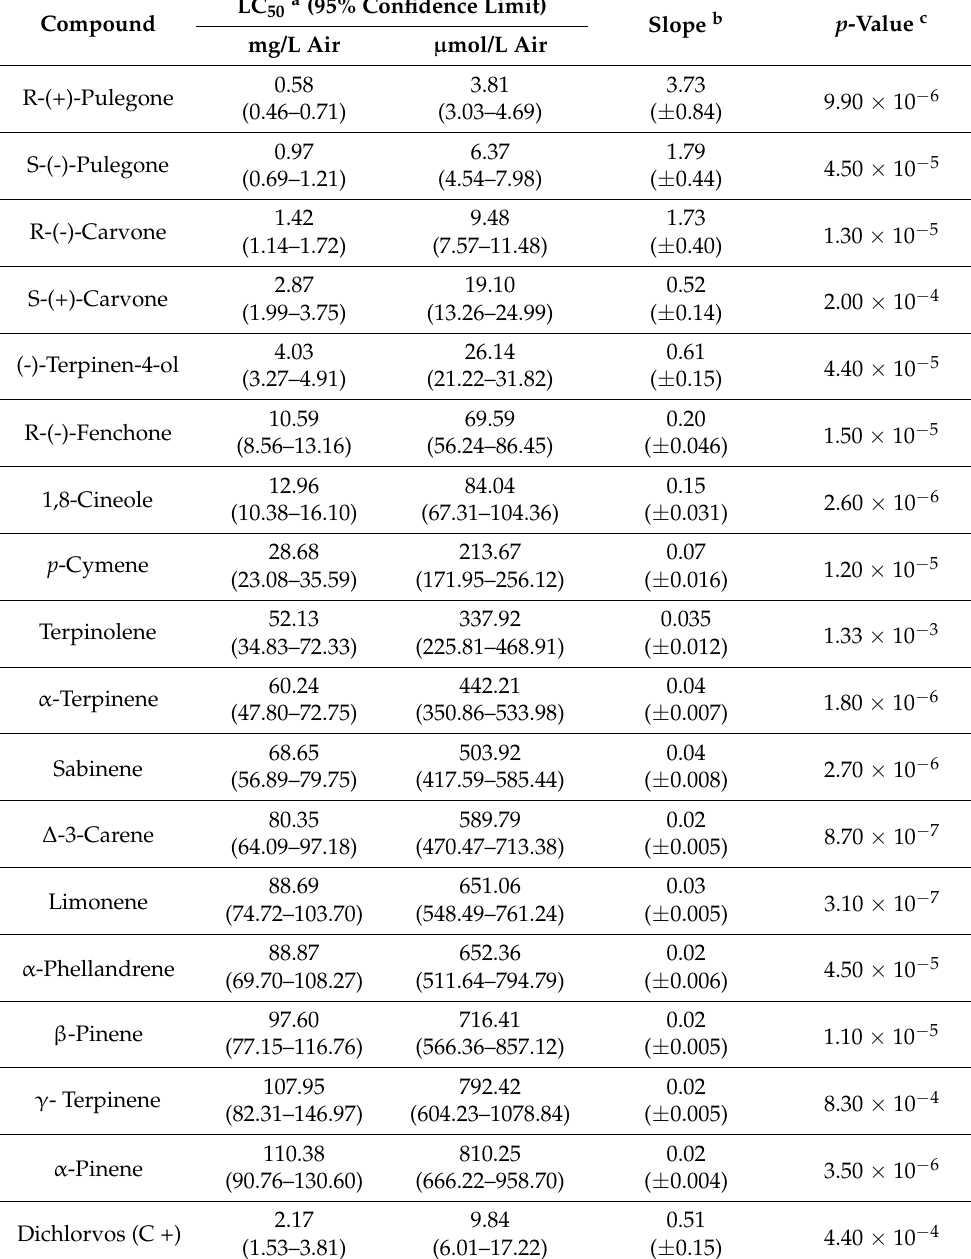
Table 5. Fumigant toxicities for the 17 active ICs, expressed as median lethal concentrations (LC 50 ).